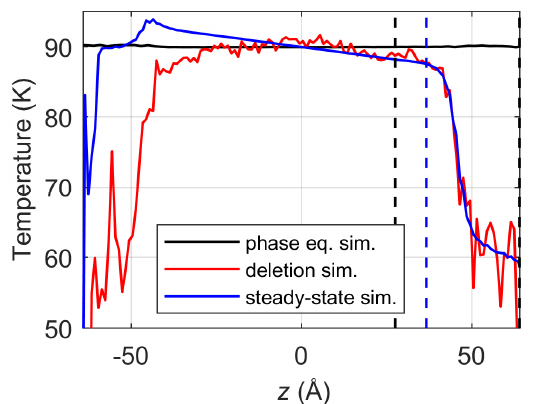
Figure 5. A phase equilibria simulation temperature profile comparison with the temperature profiles obtained from the deletion vacuum simulation and the steady-state vacuum simulation. The vertical dotted lines represent the liquid/thermostat and vapor boundary positions of the right-side interface, respectively, while the blue dotted line represents the liquid surface position located at coordinate 𝑧 ∗ = 0 . Note: the deletion vacuum simulation temperature profile is slightly shifted so that the right-side interfaces from all three simulations would coincide.